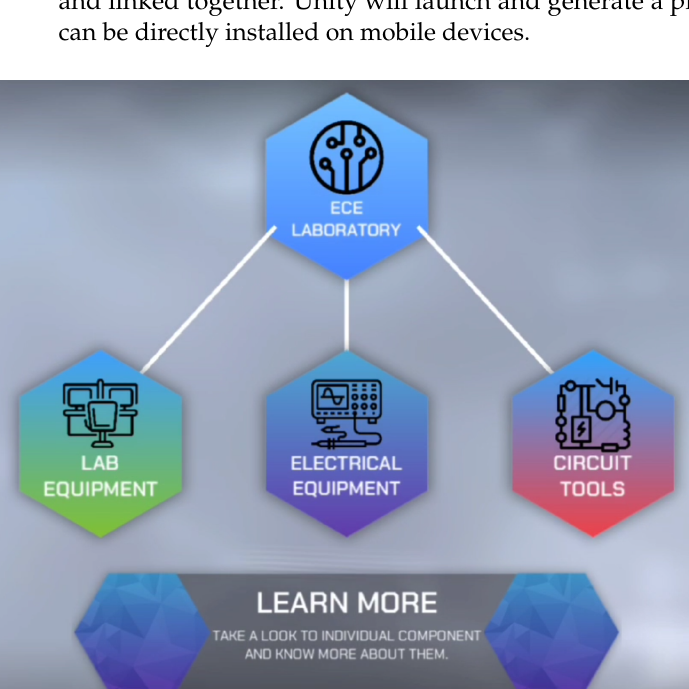
Figure 7. Main menu interface.